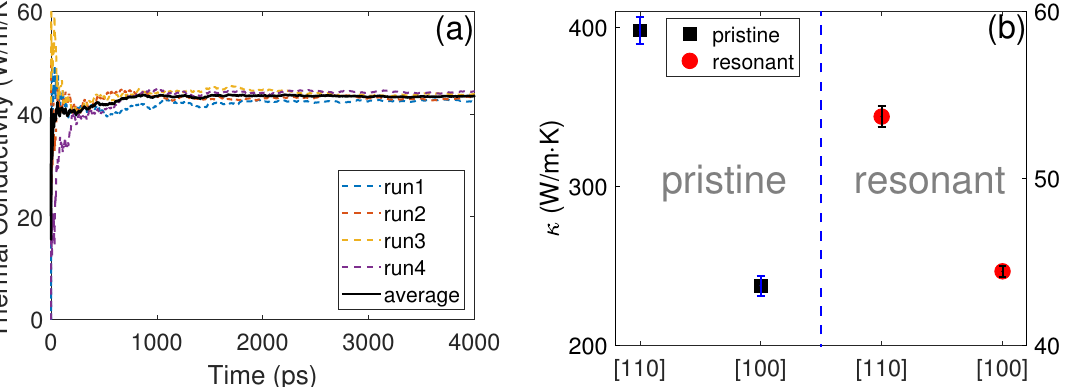
Figure 2. ( a ) Running TC along the [100]-direction of the resonant membrane with the variation of simulation time. ( b ) The TCs along the [100]- and [110]-directions for both the pristine and resonant membranes. The value for the pristine structures refers to the left y -axis and the value for the resonant structures refers to the right y